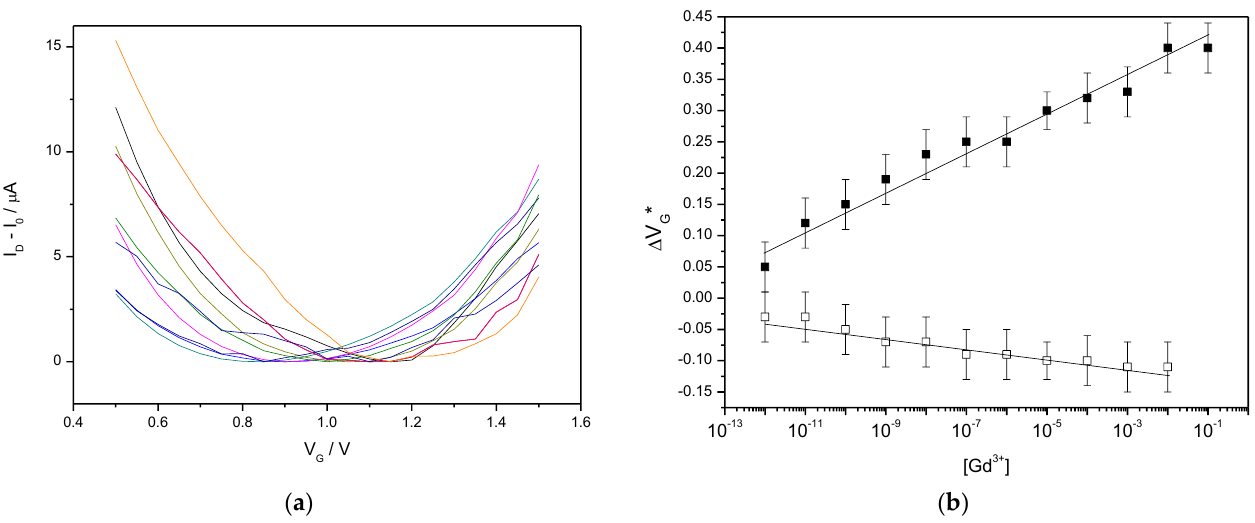
Figure 4. ( a ) Transfer curves of a DO3A-alkyne-functionalized EGGFET, for V G swept from +1.5 V down to +0.5 V, for Gd 3+ concentrations ranging from 10 −1 2 to 10 −3 M, from left to right (on color per concentration). The minimum current 𝐼 𝐷𝑚𝑖𝑛 was subtracted from all curves so that all minima are artificially set to 0. ( b ) Change of the position of the minimum V G * of the above transfer curves for various Gd 3+ concentrations, on a DO3A-alkyne-functionalized EGGFET (black squares) and on a non-functionalized EGGFET (white squares). The electrolyte always contains 0.1 M KCl. Another experiment was performed on a DO3A-alkyne-functionalized EGGFET for which the concentration of interfering ion Ca 2+ was changed, and on a DO3A-functionalized EGGFET for which the concentration of Gd 3+ was changed in a medium containing all the potential interfering ions Ni 2+ , Ca 2+ , Na + et In 3+ at 10 −6 M, plus 0.1 M KCl (Figure 5). These experiments show a V G * that is insensitive to the concentration of Ca 2+ ions, whereas it shifts of ca. 20 mV.dec −1 for Gd 3+ in a mixture of other ions.